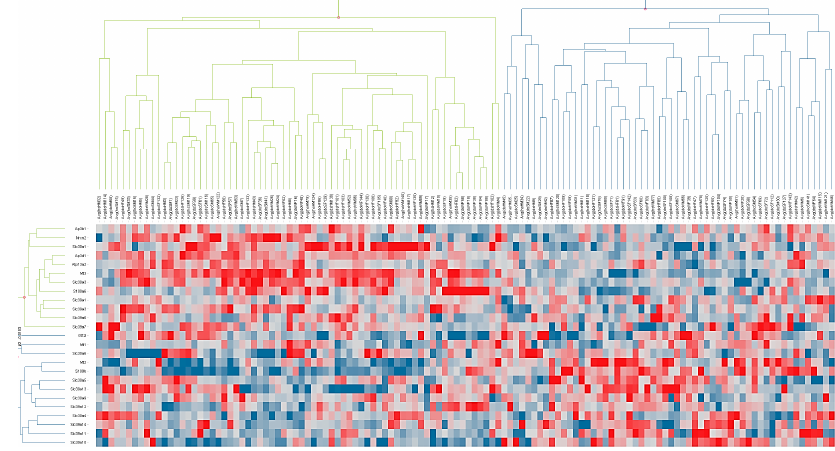
Figure 1. Hierarchical clustering of gene expression profiles related to the expression of Zn transporters. Genes coding for Zn transporters are shown as rows, and individually tested animal samples are shown as columns. The expression changes in the heat map are represented by z-scores that are color-coded according to their values: red squares correspond to positive changes in expression levels (upregulation); blue squares correspond to negative changes in gene expression (downregulation); and white represents the absence of changes. Hierarchical clustering of the gene expression profiles revealed the presence of two distinct groups of animals, shown as green and blue trees, respectively, on the top of the figure. Table 2. Zn transporter genes that differentiate the two identified animal groups. Eleven genes, shown in red and blue, account for the major differences between the two animal groups identified in Figure 1. Other Zn transporter genes do not show statistically significant changes in expression levels between the groups. Among the 11 differentially expressed genes, two ( Mt2 and S100b , shown in blue) are upregulated in the animal Group A as compared to Group